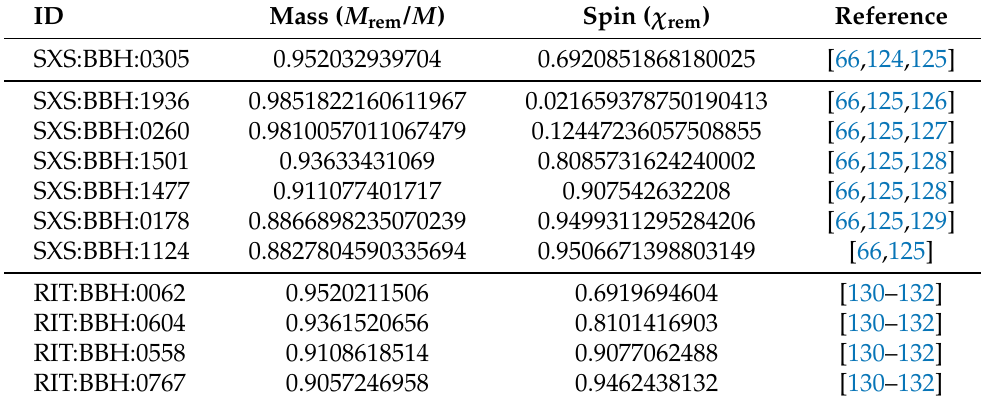
Table A1. Masses and spins of remnant BHs from NR simulations of binary BHs examined in this Appendix. M rem / M and χ rem are the nondimensional mass ans spin parameters, respectively. The ‘SXS’ data is presented in the Simulating eXtreme Spacetimes (SXS) catalogue [66], while the ‘RIT’ data is imported from the CCRG@RIT Catalog of Numerical Simulations [67]. Each reference in the table is cited from the corresponding metadata file. SXS:BBH:0305 is used in Section 6, and the remaining NR data are studied in Appendices A and